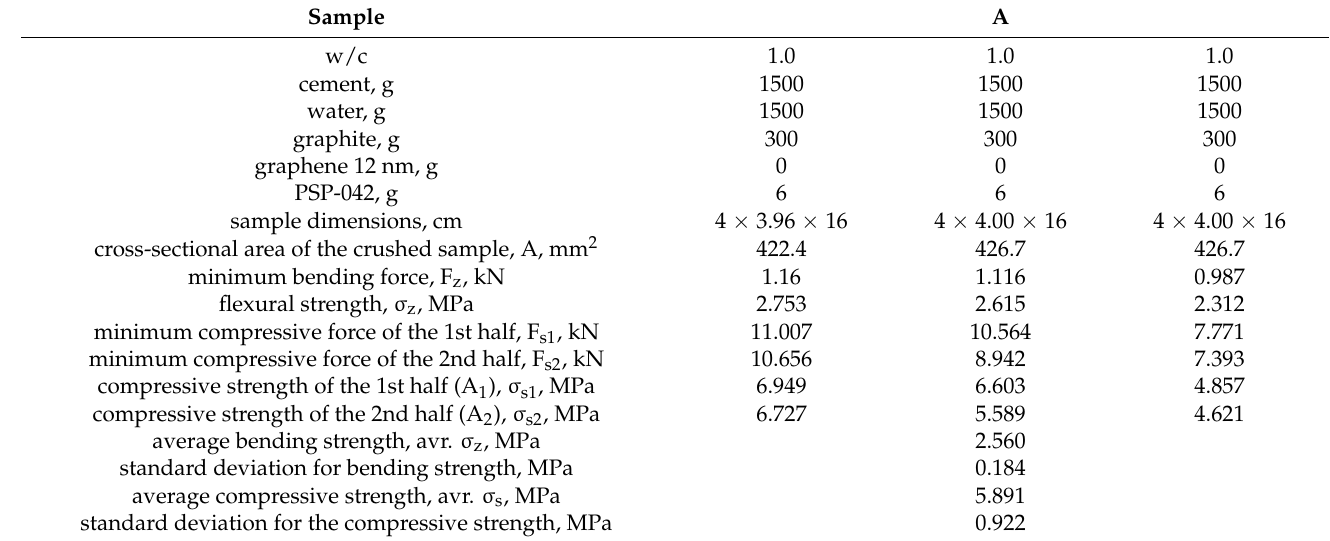
Table 2. Strength test results of the hardened sealing slurries: sample A.